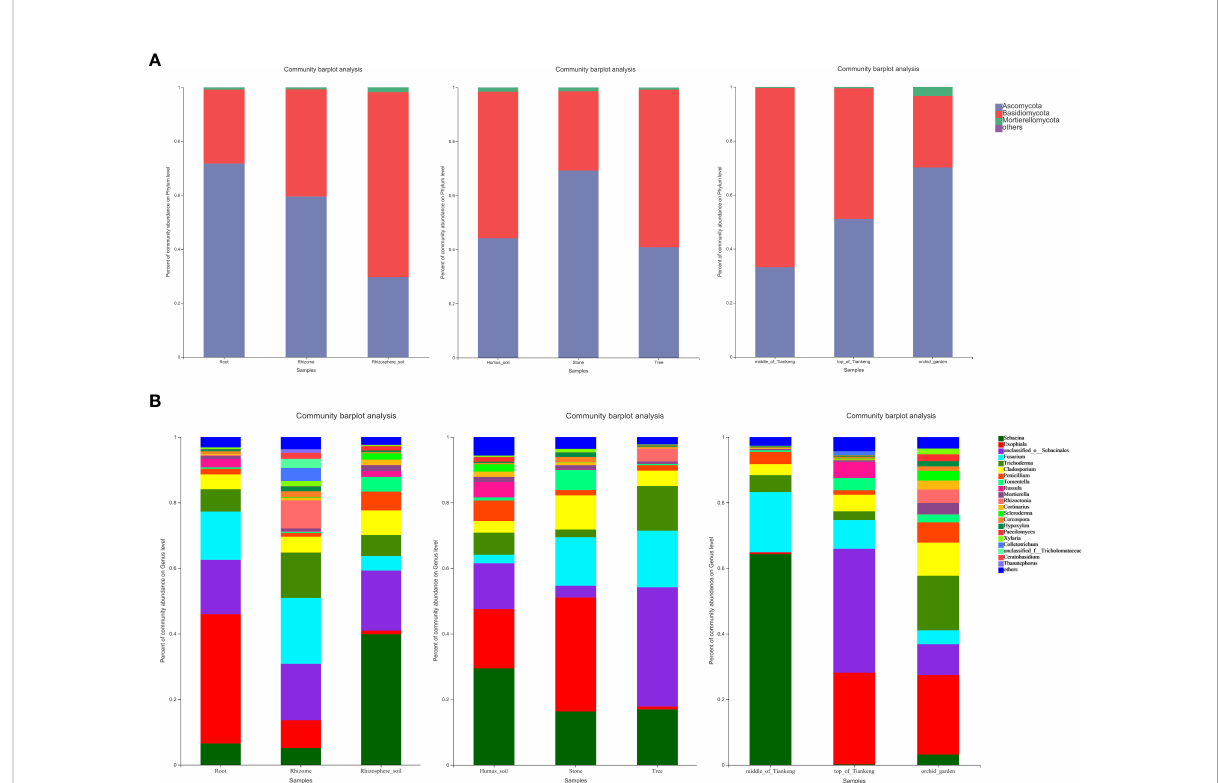
FIGURE 4 Bar diagram of mycorrhizal fungal community composition. The abscissa is the sample name, and the ordinate is the proportion of species in the sample. Columns with different colors represent different species, and the length of the column represents the proportion of the species. Composition of mycorrhizal fungi is at Phylum (A) and Genus levels (B)